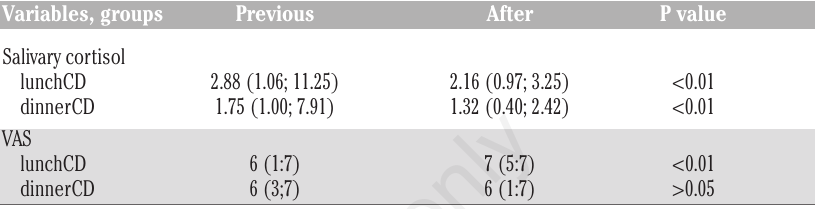
Table 2. Salivary cortisol and visual analogy scale in inpatient children previous and after clown-doctors